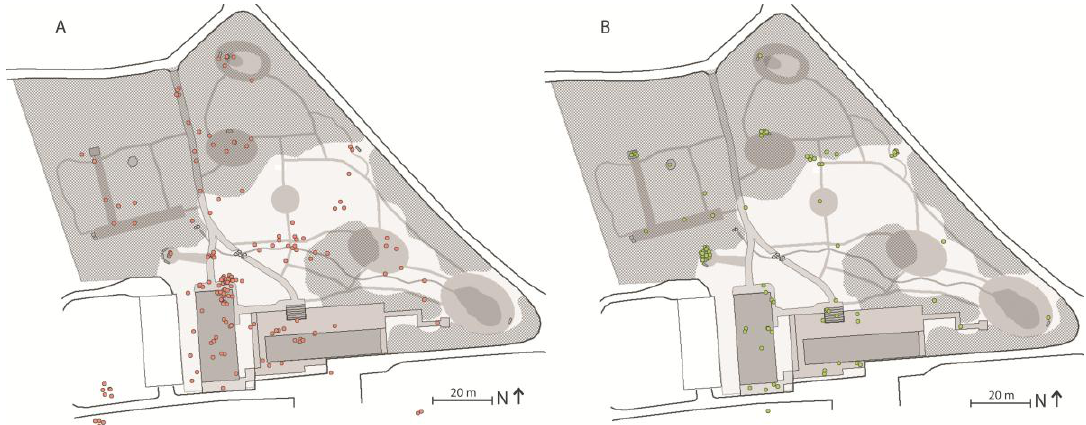
Figure 9. ( A ) Distribution of garden activities as observed from August 2013 to March 2015; ( B ) Distribution of individual conversational therapy as observed from August 2013 to March 2015.